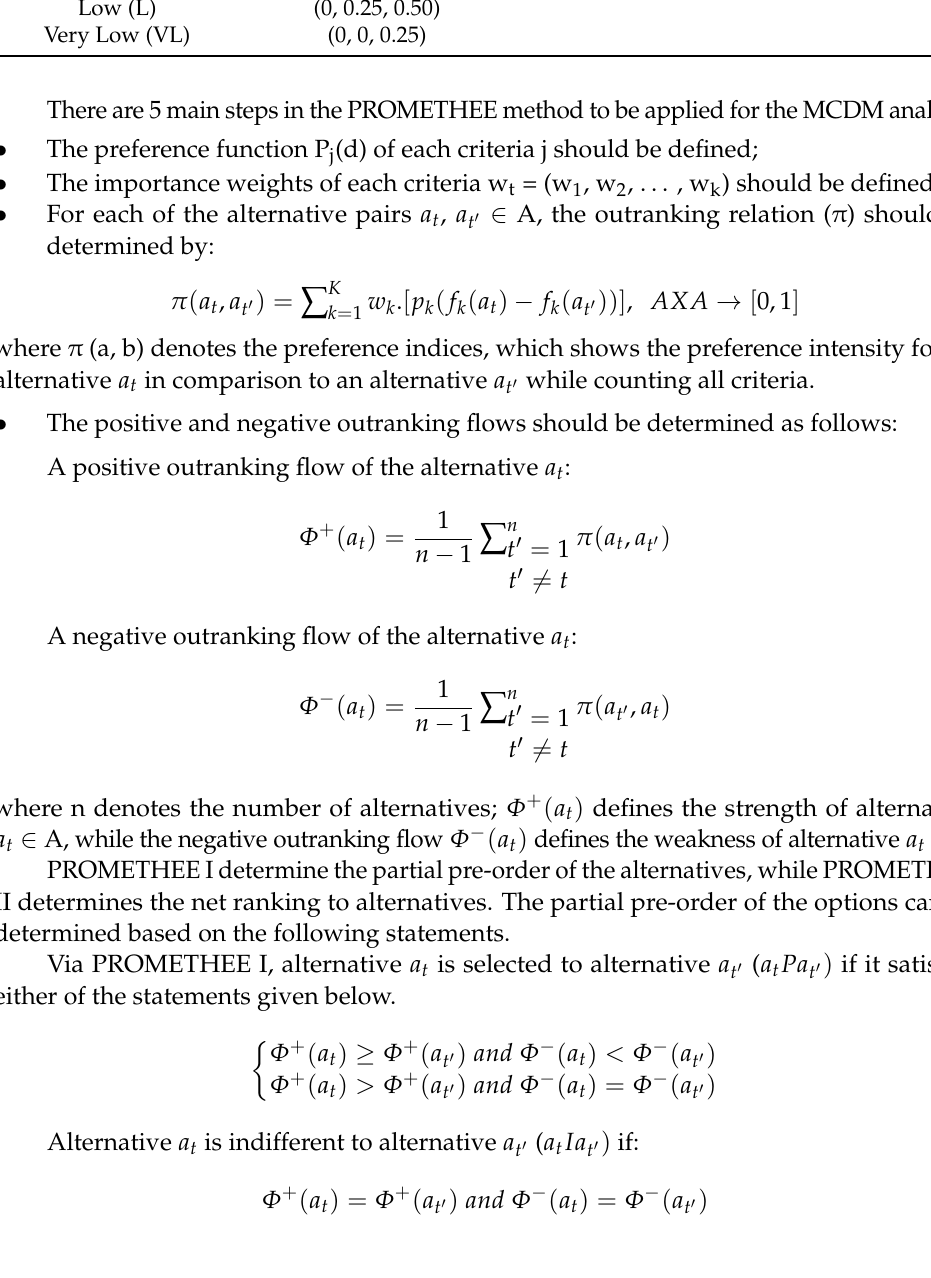
Table 1. Linguistic fuzzy scale of the assigned weights of importance to the criteria. VH: very high; H: high; M: medium; L: low; VL: very low. Linguistic Scale Triangular Fuzzy Scale Criteria Very High (VH) (0.75, 1, 1) Specificity, brain uptake, and penetration High (H) (0.50, 0.75, 1) Target binding affinity Medium (M) (0.25, 0.50, 0.75) Adverse reactions Low (L) (0, 0.25, 0.50) Very Low (VL) (0, 0,